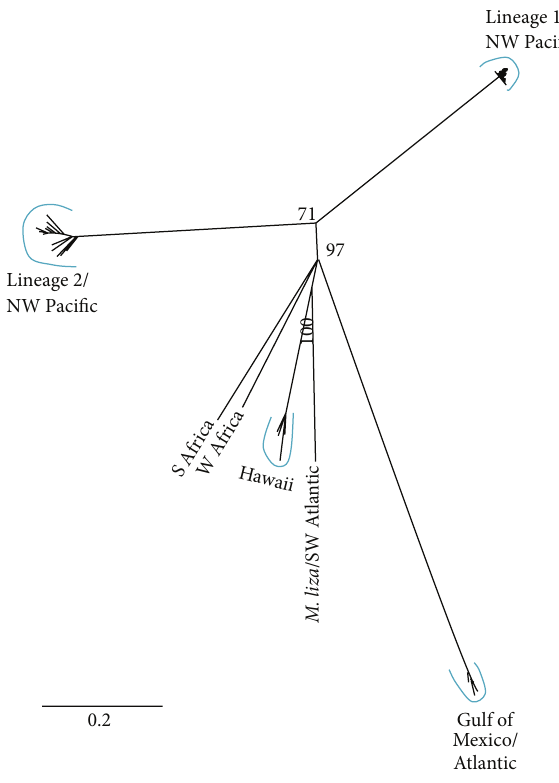
Figure 4: Transition (Ts) and transversion (Tv) over genetic distance (Tamura-Nei TrN-G) plot inferred from the whole CR of Mugil cephalus